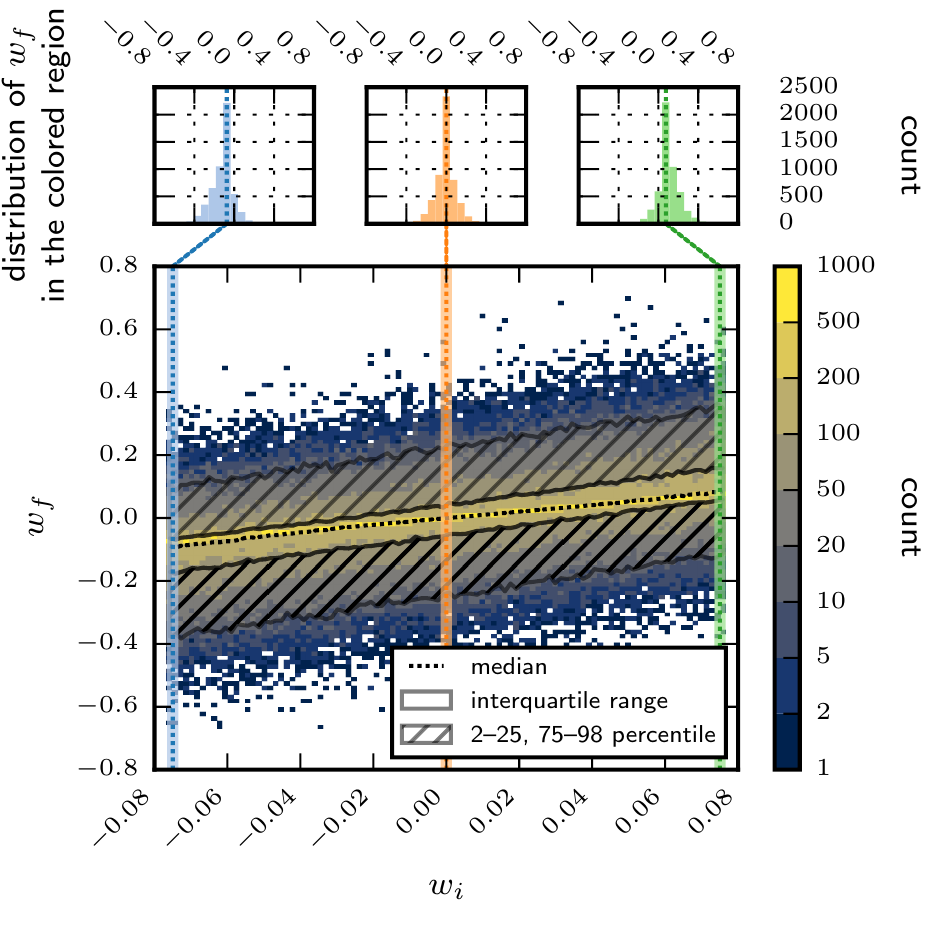
Figure 3. Distribution of the final values of the weights of the network of Figure 1a, trained for 1000 epochs on HASYv2, as function of their initial value. The peak of the distribution is at w f = w i , which is extremely close to the median. The skewness of the distribution for large absolute values of w i is evidenced in the histograms at the